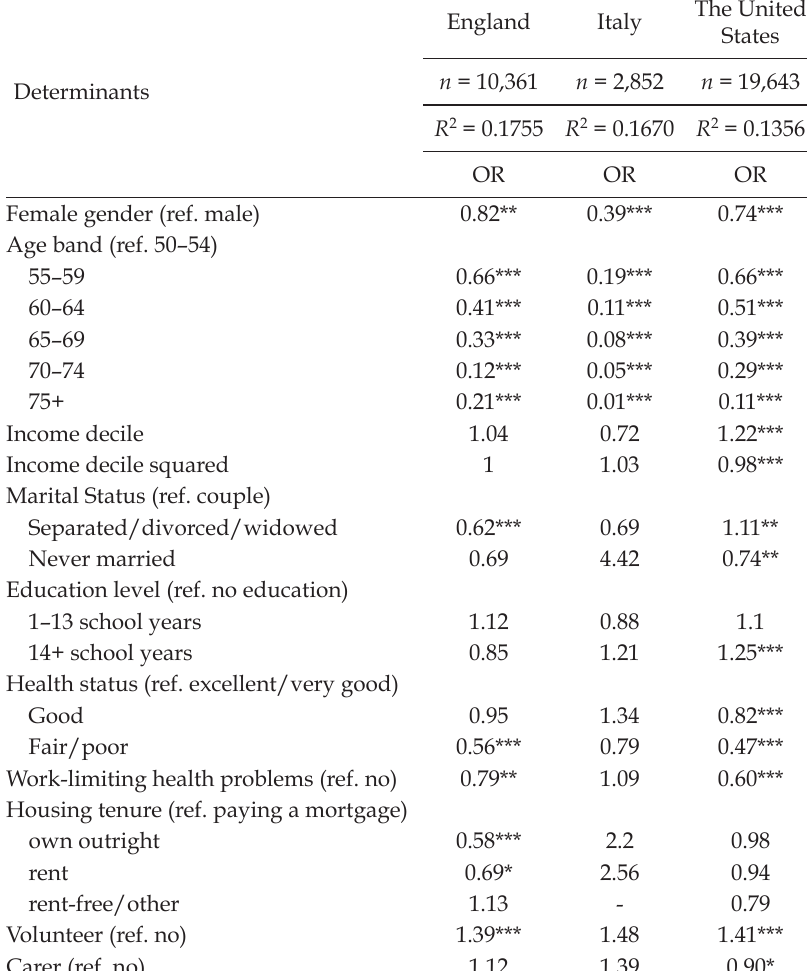
Table 1. Multivariate logistic regression – determinants of reverse retirement